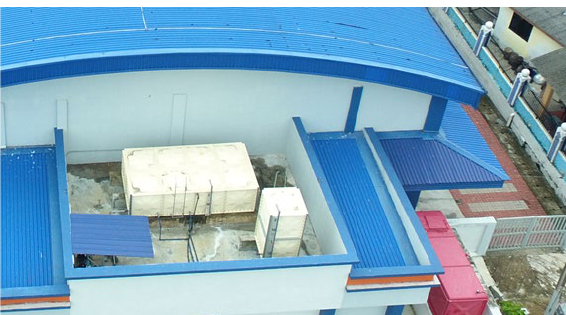
Figure 10. Inaccessible area for TLS which UAV can